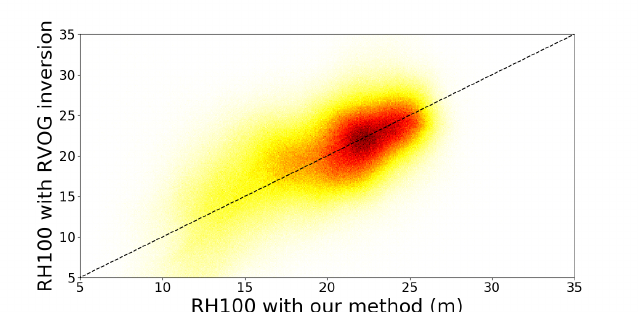
Figure 20. Density plot of RH100 estimated by a RVoG based inversion method VS our seven parameter machine learning-based